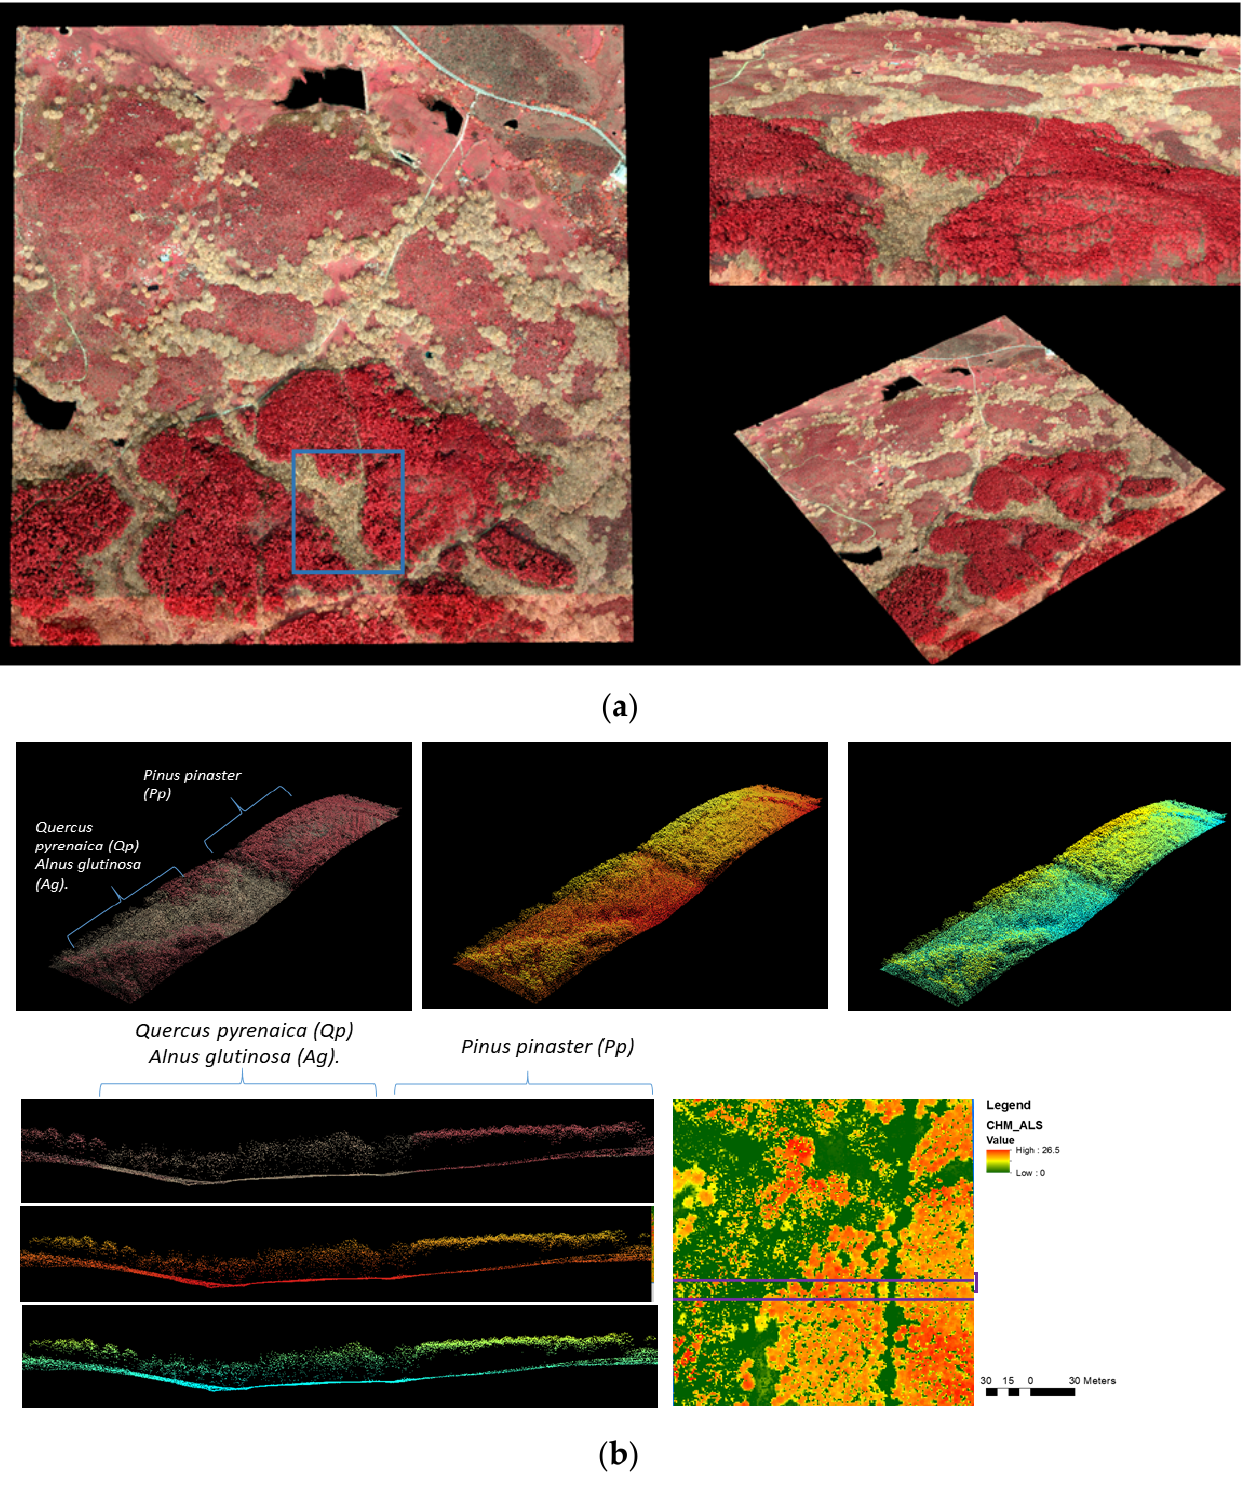
Figure 4. The study area (blue boundary) over the ALS data displaying the three main tree species in the study area ( a ). Detailed overview (representing the profiles of infrared, intensity and elevation from ALS point clouds) of the main species represented in the marteloscope and CHM from the study area under leaf‑off condition of Quercus pyrenaica and Alnus glutinosa species ( b